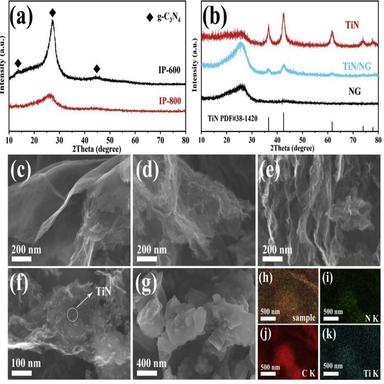
(a) XRD patterns of the IP-600 and IP-800. (b) XRD patterns of the NG, TiN/NG and TiN. SEM images of the (c) NG, (d) IP-800, (e-f) TiN/NG and (g) TiN. (h-k) The element mappings of the TiN/NG.